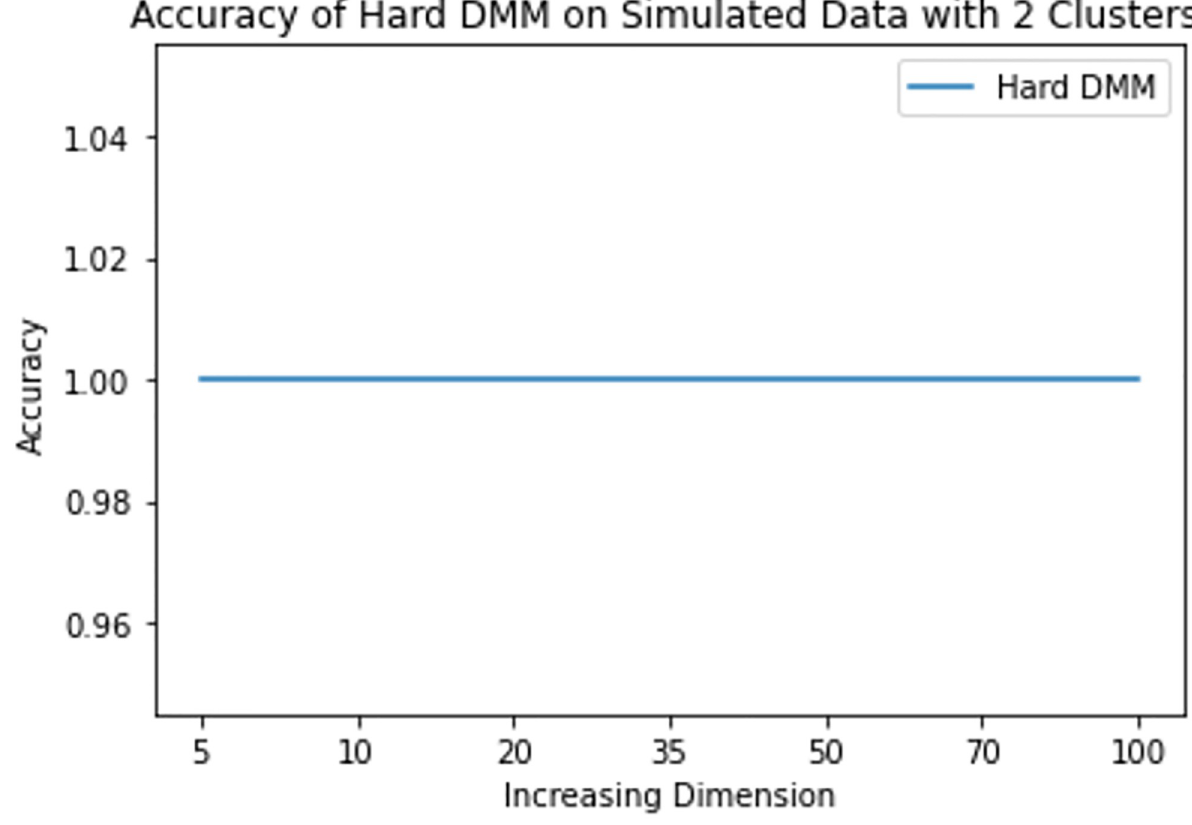
Fig 9. Mean accuracy of hard DMM 1 with 2 clusters and varied